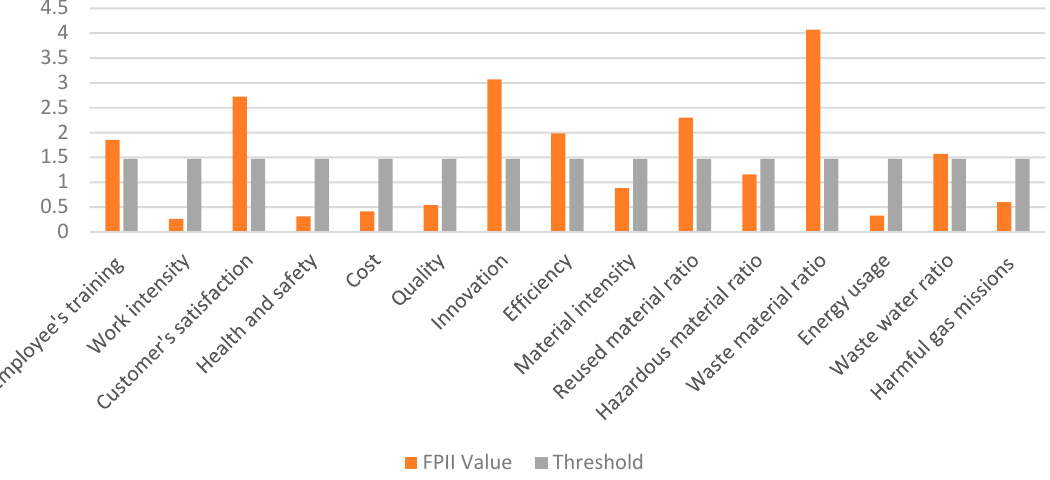
Figure 4. Demonstration of weak points in terms of FPII value.